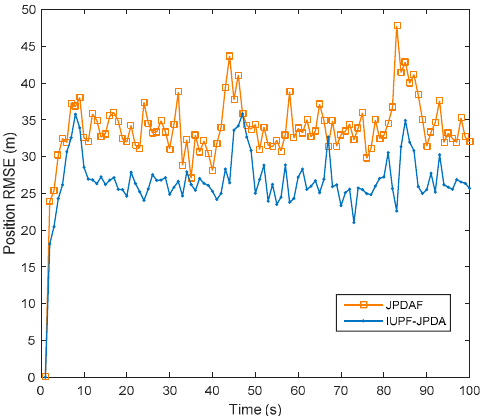
Figure 11. Comparison of position RMSE for target 1 in a multi-target simulation experiment.